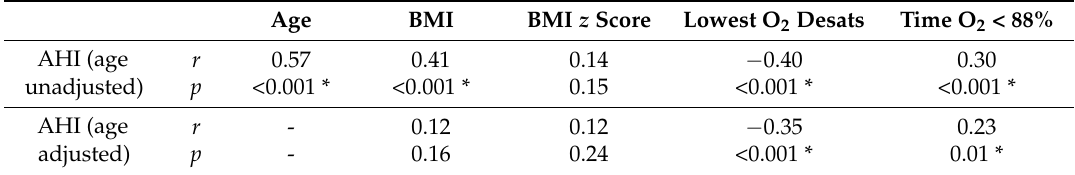
Table 2. Correlation between sleep disordered breathing indices and other characteristics.